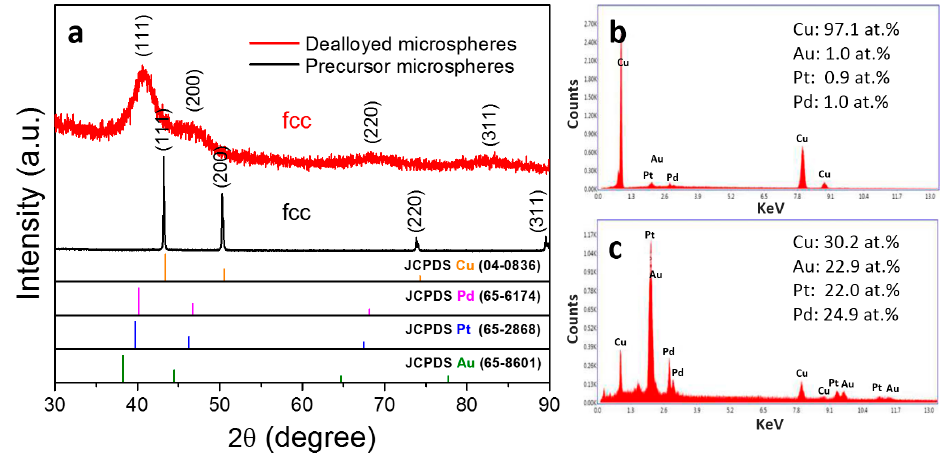
Figure 2. ( a ) XRD patterns of the precursor microspheres before and after dealloying in 2 M HNO 3 for 24 h. EDS analysis of the precursor microspheres before ( b ) and after ( c ) dealloying in 2 M HNO 3 for 24 h.